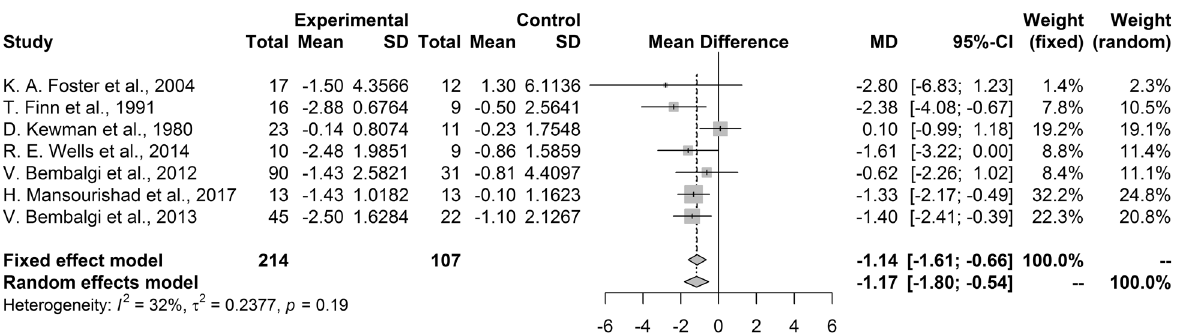
Fig. 3 Forest plot of headache frequency measured by number of headache